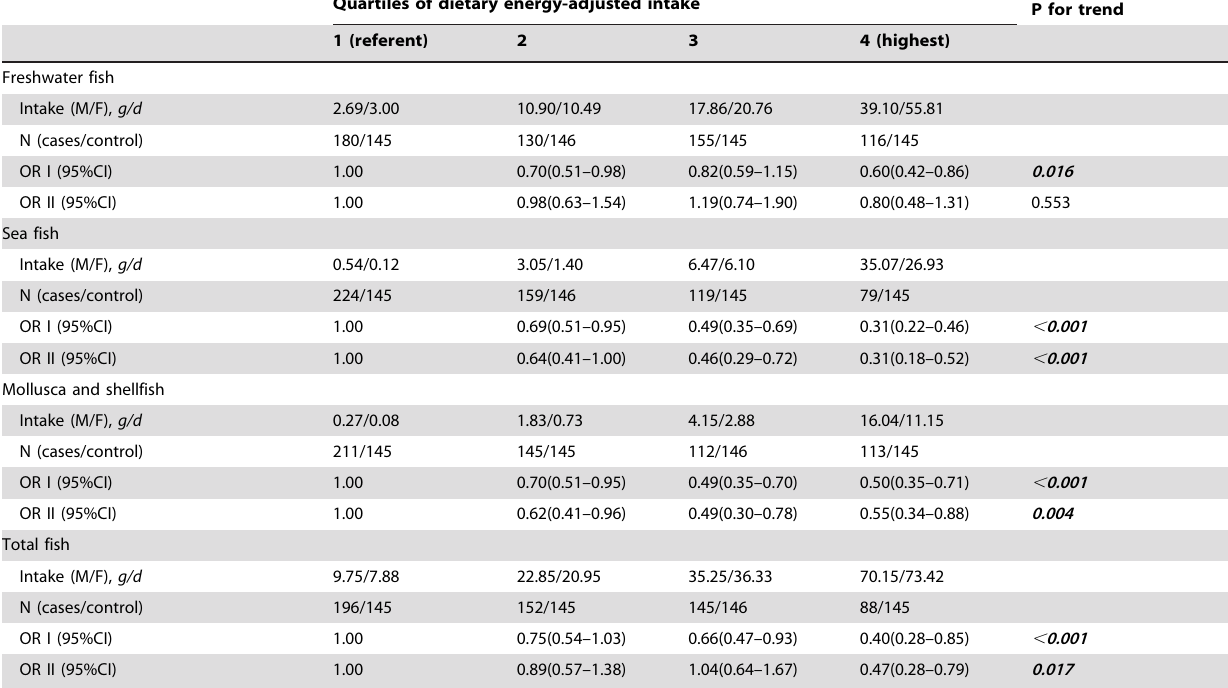
Table 4. Odds ratio (95% CIs) of hip fractures for quartiles of seafood intake in Guangzhou,